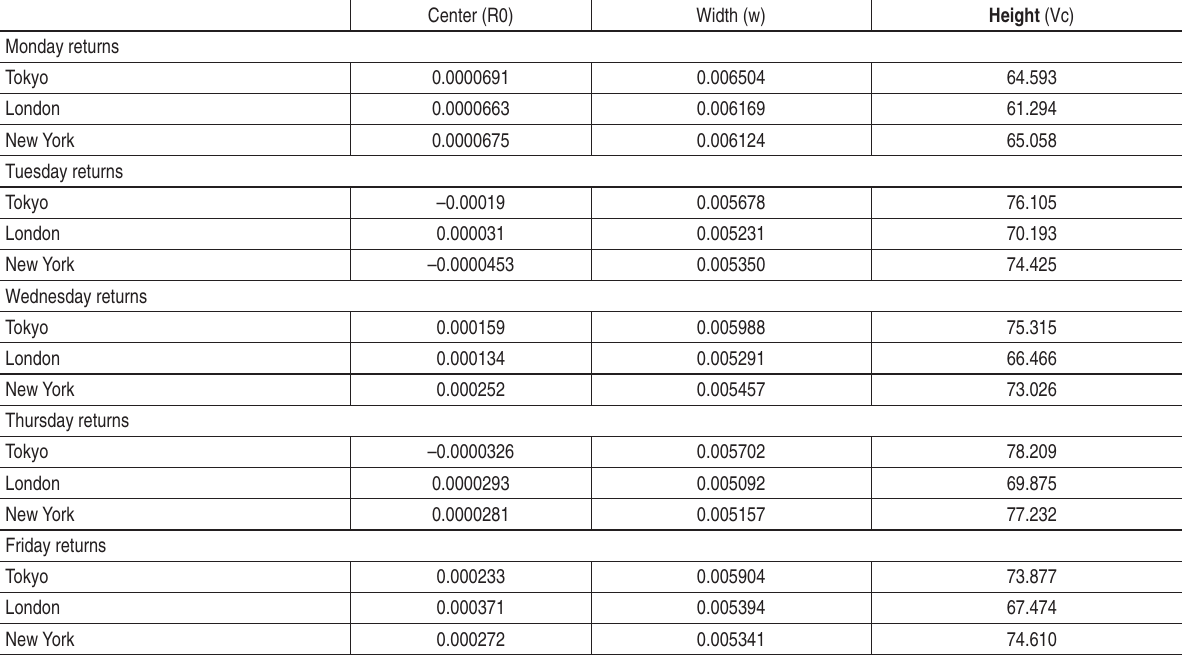
Table 4. Parameter estimates of weekday returns of the Gaussian function of Tokyo, London and New York Center (R0) Width (w) Height